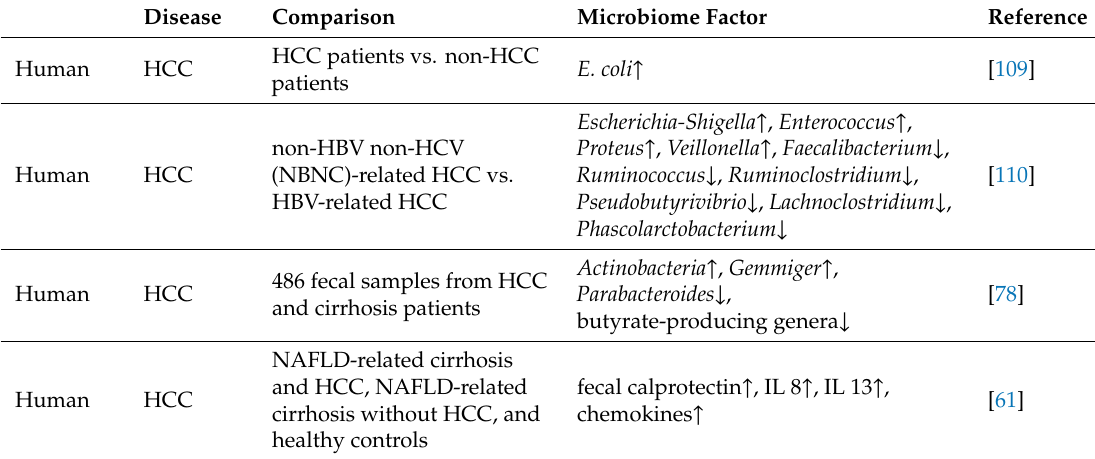
Table 2. Clinical studies on relation between the microbiome and hepatocellular carcinoma.